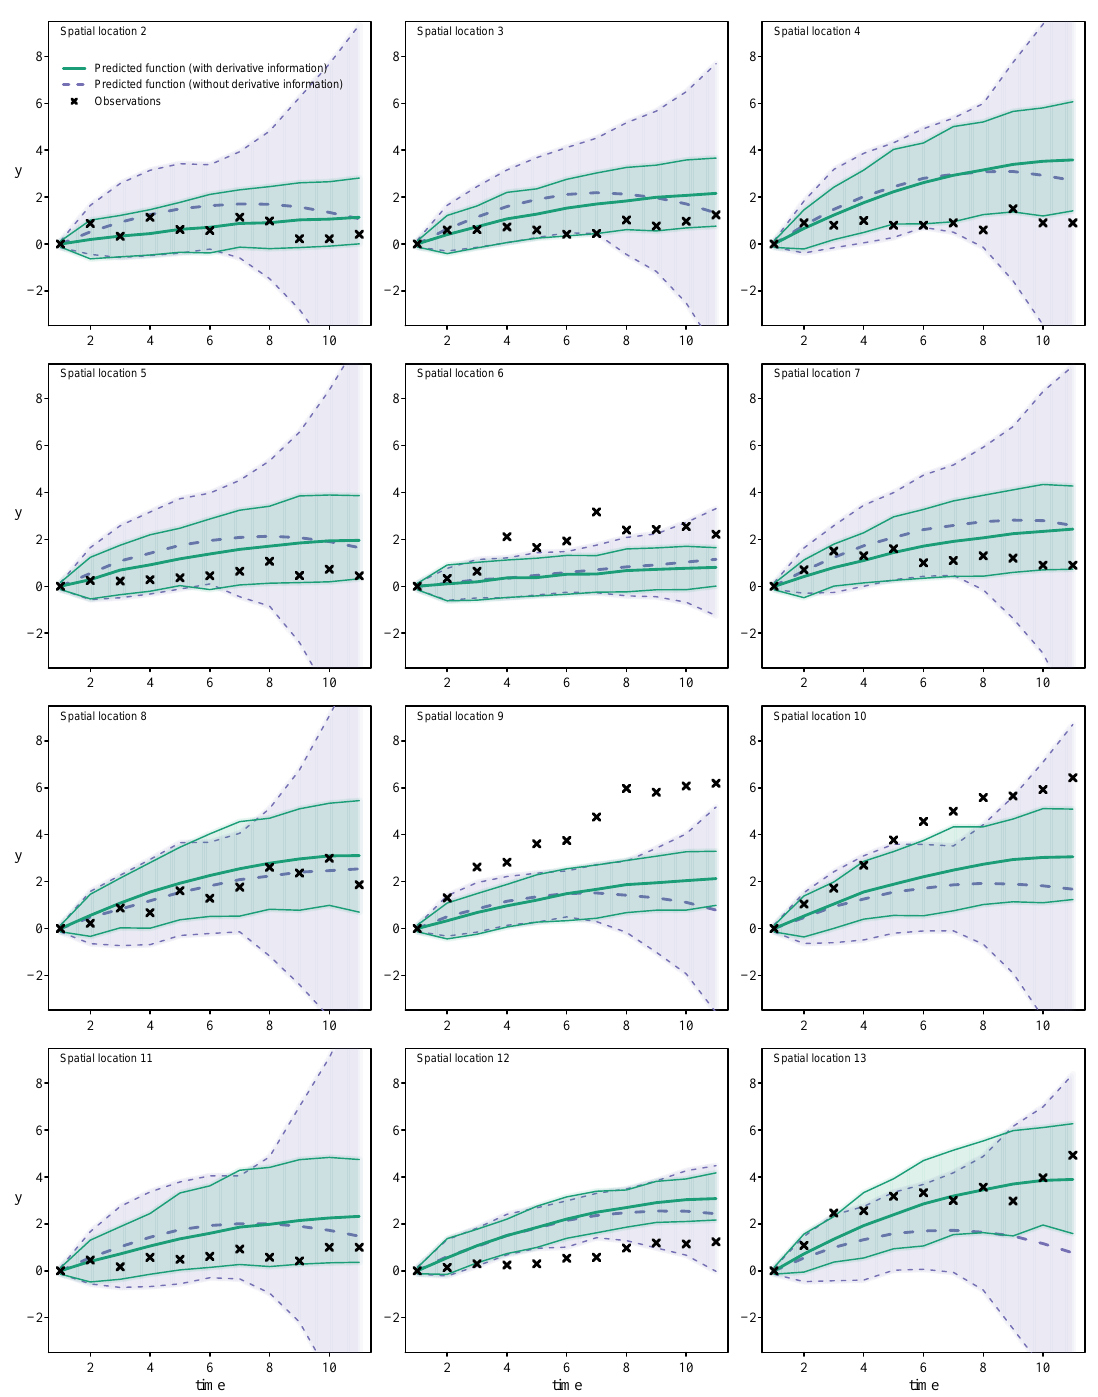
Figure 6. Predicted means and 95% pointwise credible intervals of new time series for predicting locations in the lolo-cv scheme, for both models, with and without derivatives. The actual data y have also been plotted as